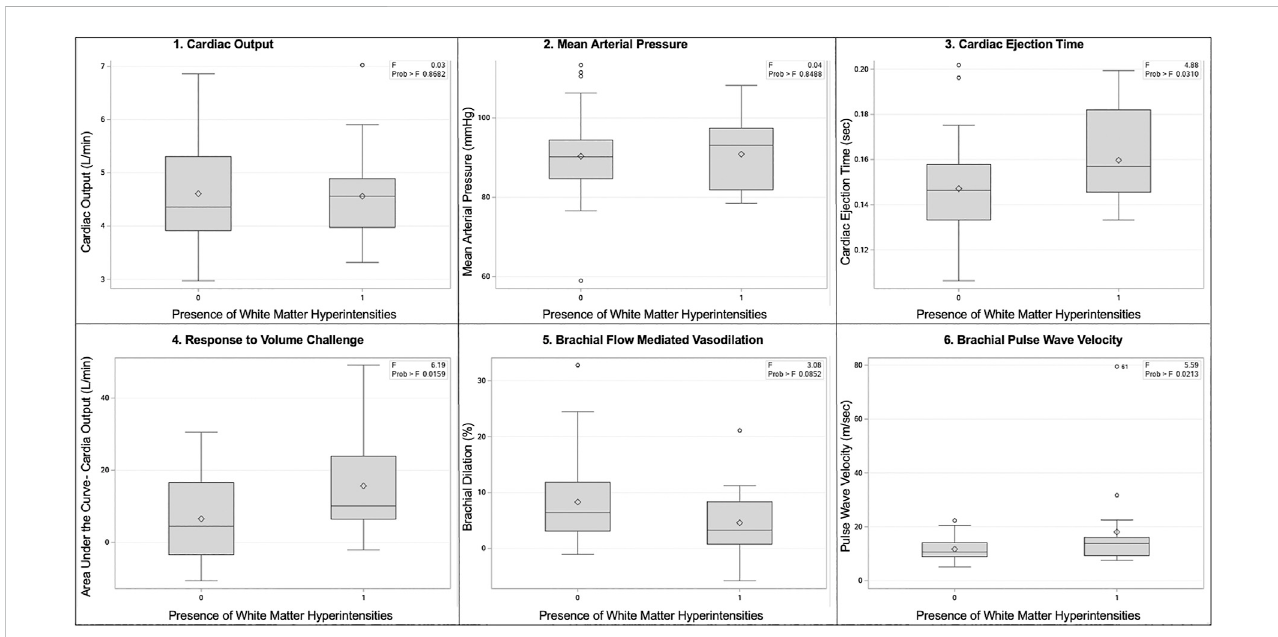
FIGURE 3 Box and whisker plots of select physiologic comparisons based on the presence or absence of white matter hyperintensities. Panels are as follows: 1) cardiac output, 2) mean arterial pressure, 3) cardiac ejection time, 4) response to volume challenge, 5) brachial fl ow mediated vasodilation, 6) brachial pulse wave